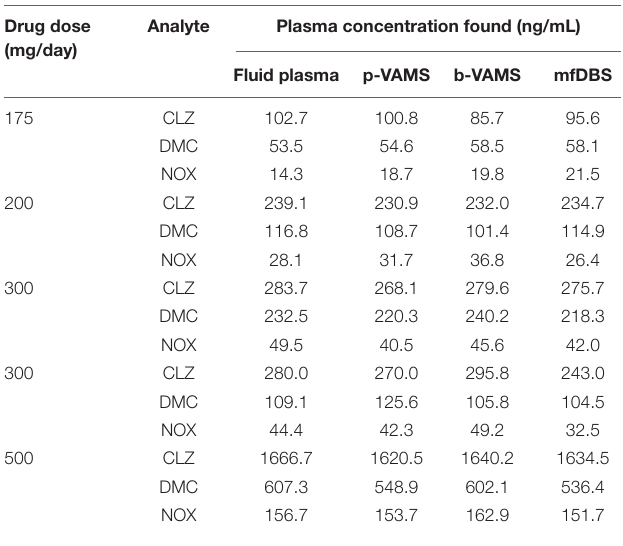
TABLE 3 | Quantitative comparisons among wet and dried samples obtained from patients undergoing CLZ therapy. Drug dose